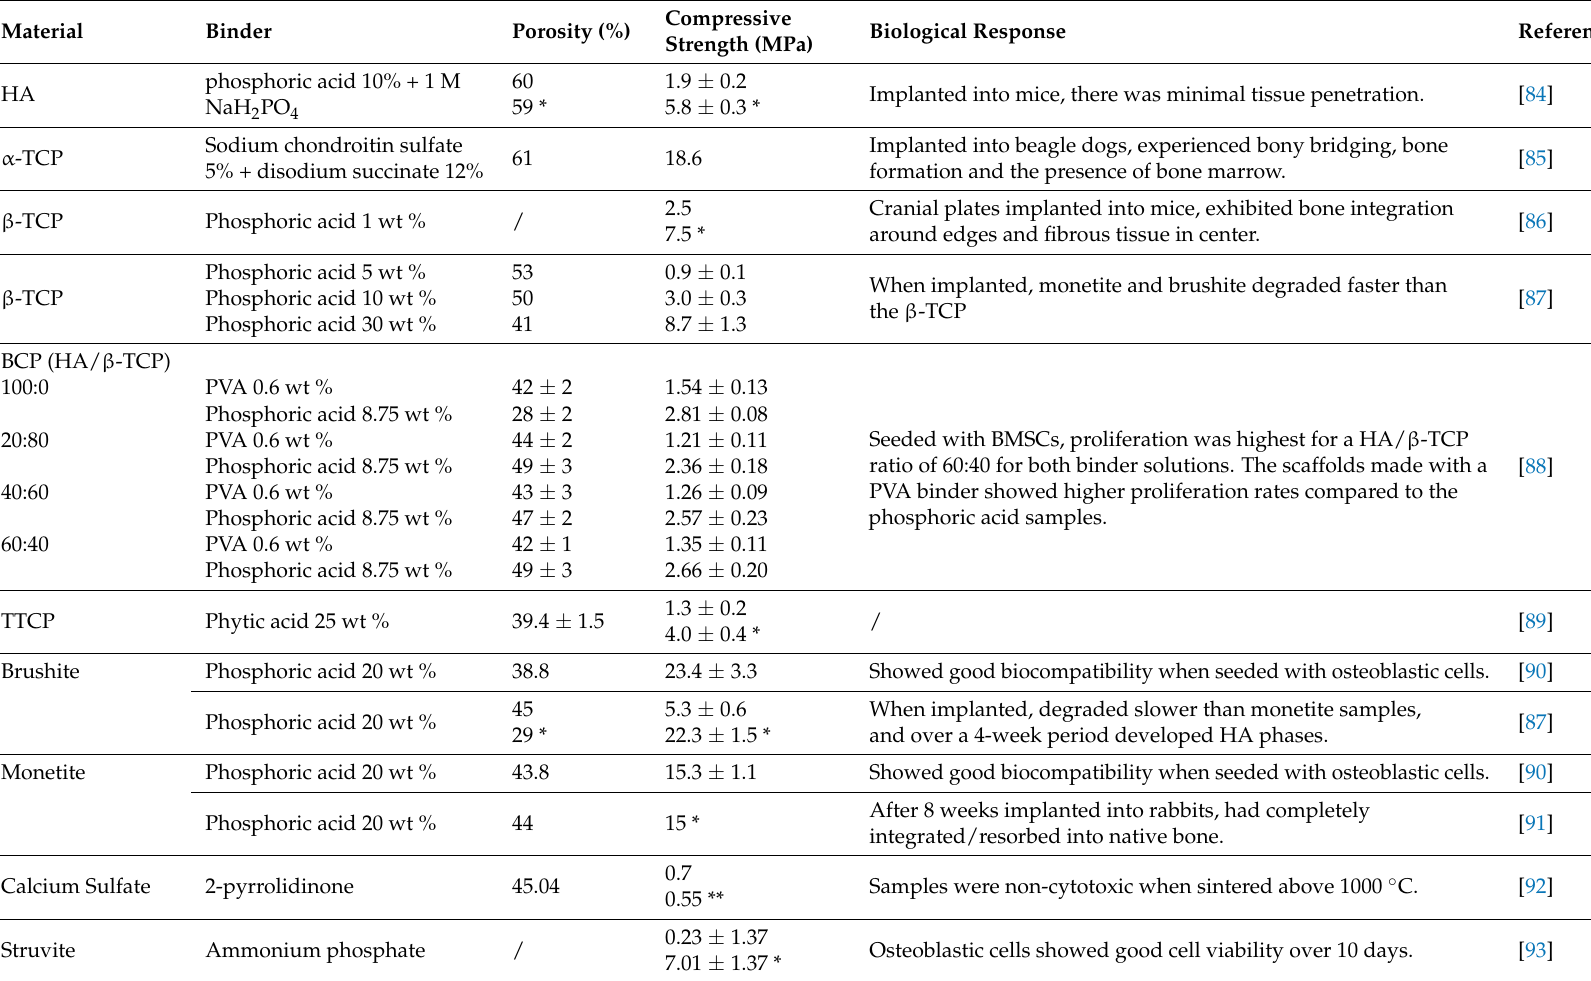
Table 3. Summary of Inkjet Printed Scaffold